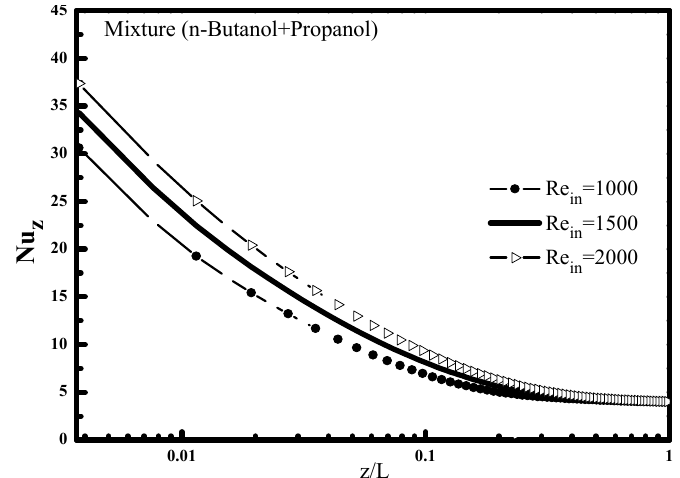
Figure 8. Variation of the Nusselt number along the tube for different Re in .